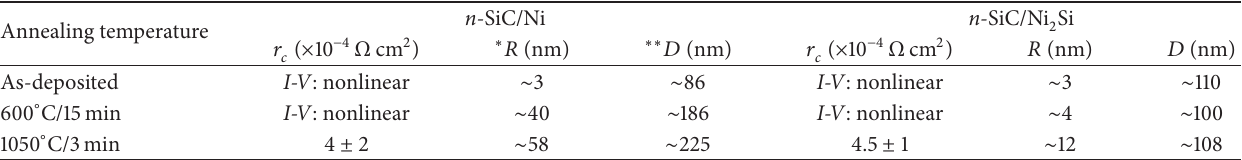
Table 2: Properties of Ni and Ni 2 Si contacts to n -type ( ∼ 2 × 10 17 cm −3 ) 4H-SiC bulk wafers versus annealing temperature. Annealing temperature